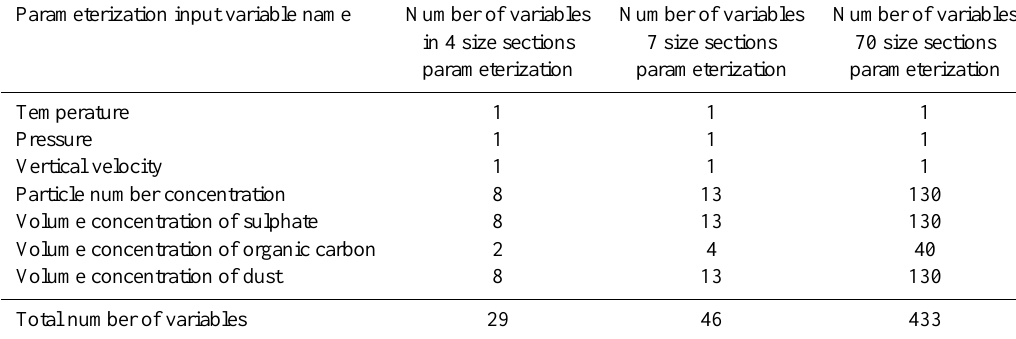
Table 1. The numbers and names of the input variables in the ARG parameterizations.